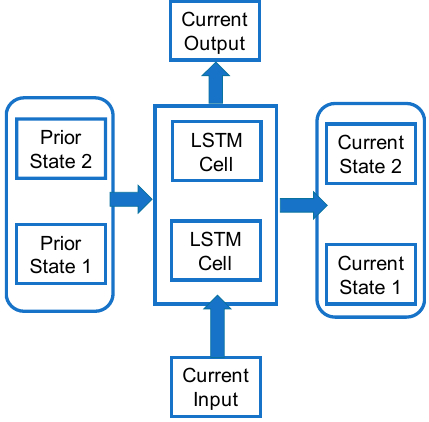
Appl. Sci. 2022 , 12 , 7909